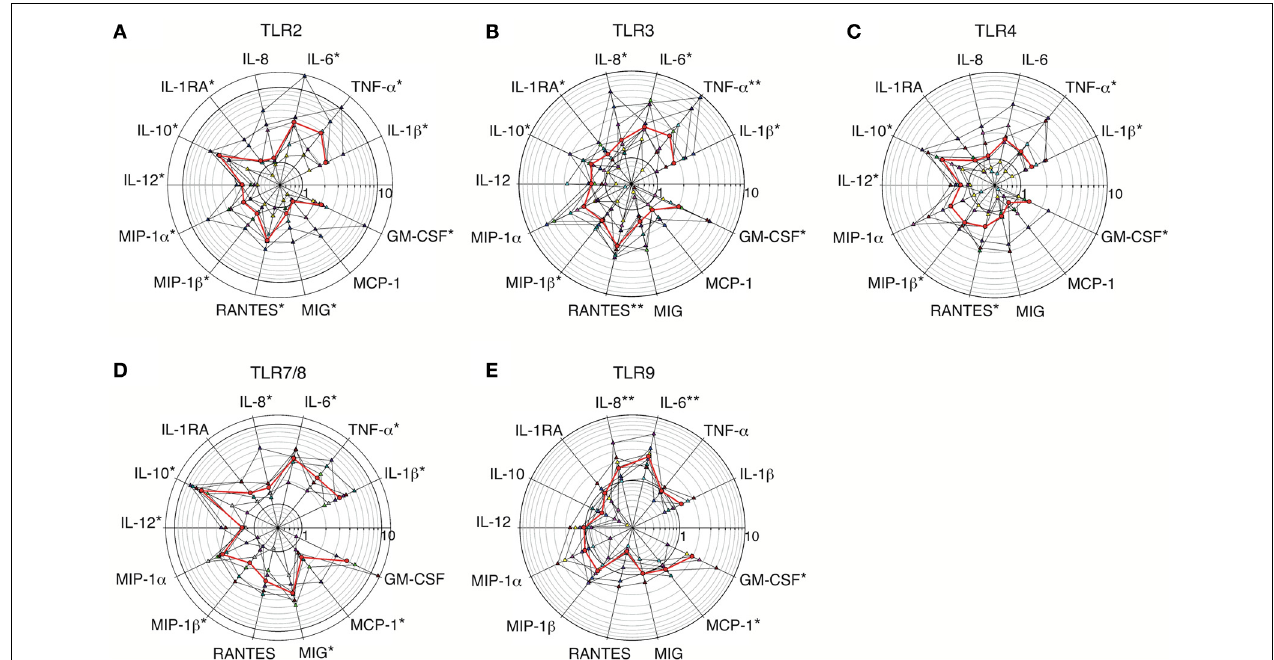
FIGURE 2 | Fold increases in cytokine secretion by dMs stimulated with TLR2, TLR3, TLR4, TLR7/8, and TLR9 agonists. Fold increases in cytokine levels in supernatants of purified dMs incubated with TLR2 agonist (HKLM, n = 7) (A) ; TLR3 agonist (poly(I:C), n = 9) (B) ; TLR4 agonist (LPS, n = 7) (C) ; TLR7/8 agonist (R848, n = 6) (D) , or